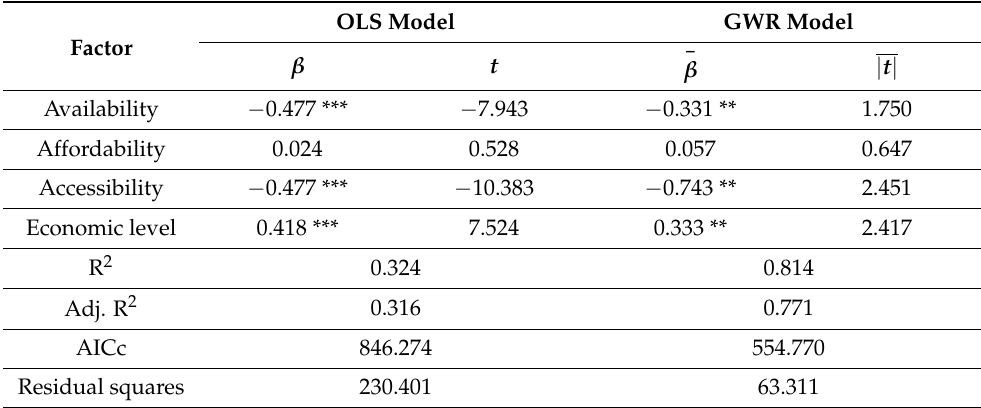
Table 1. Results of OLS multiple regression and GWR